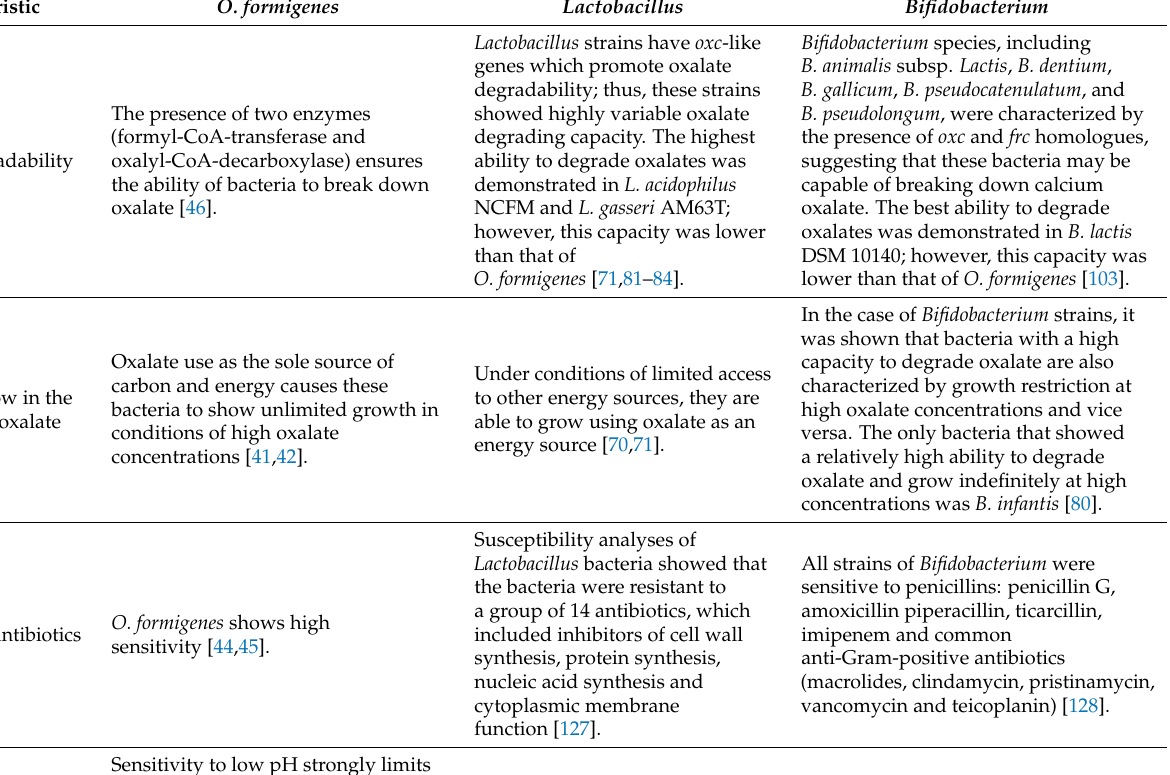
Table 8. Characteristics of O. formigenes , Lactobacillus and Bifidobacterium in the prevention of